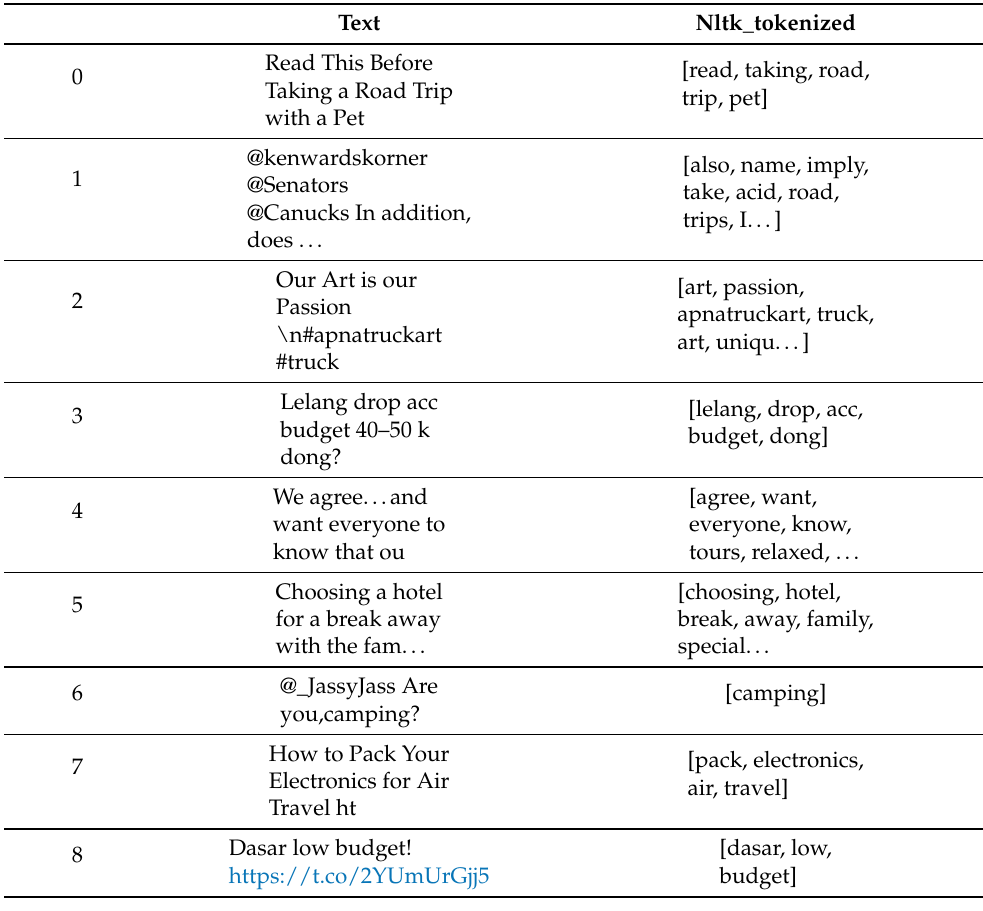
Table 4. Preprocessing results using NLTK